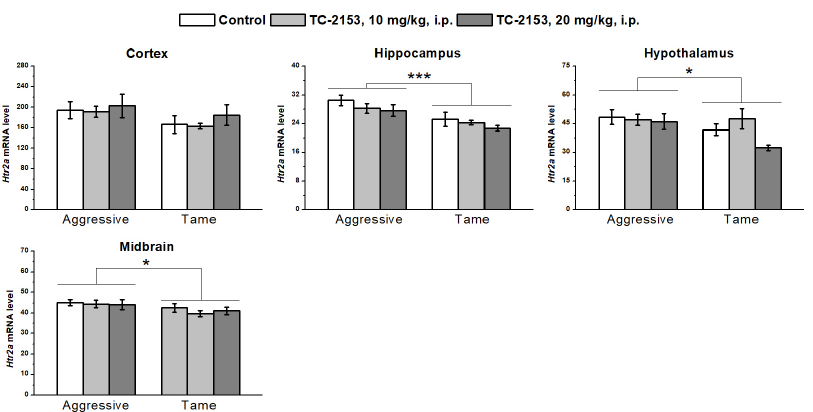
Figure 8. Effects of acute administration of vehicle (control) or TC ‐ 2153 at the dose 10 or 20 mg/kg on 5 ‐ HT 2A receptor ( Htr2a ) mRNA levels in the cortex, hippocampus, hypothalamus, and midbrain of aggressive and tame rats. The expression levels were assessed as the number of transcript copies per 100 copies of Polr2a mRNA. * p < 0.05 and *** p < 0.001 for the genotype effect (6–7 animals per